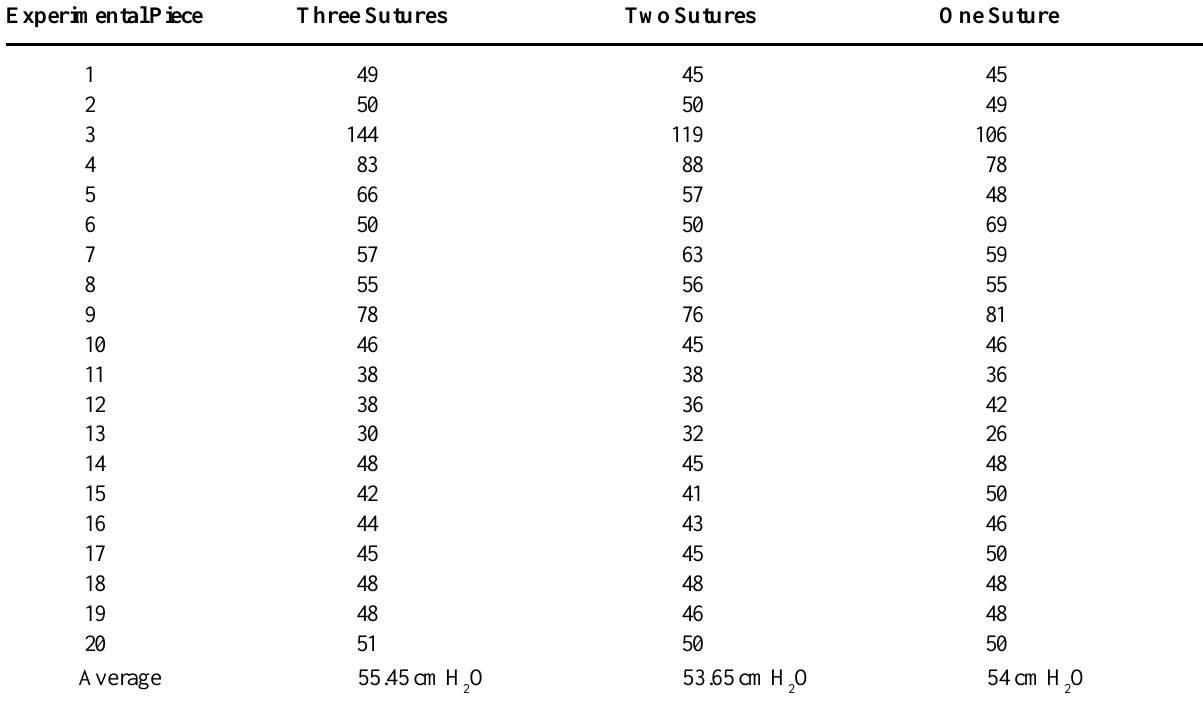
Table 2 – Maximum continence pressure of channels with 3, 2 and 1 imbrication sutures. Experimental